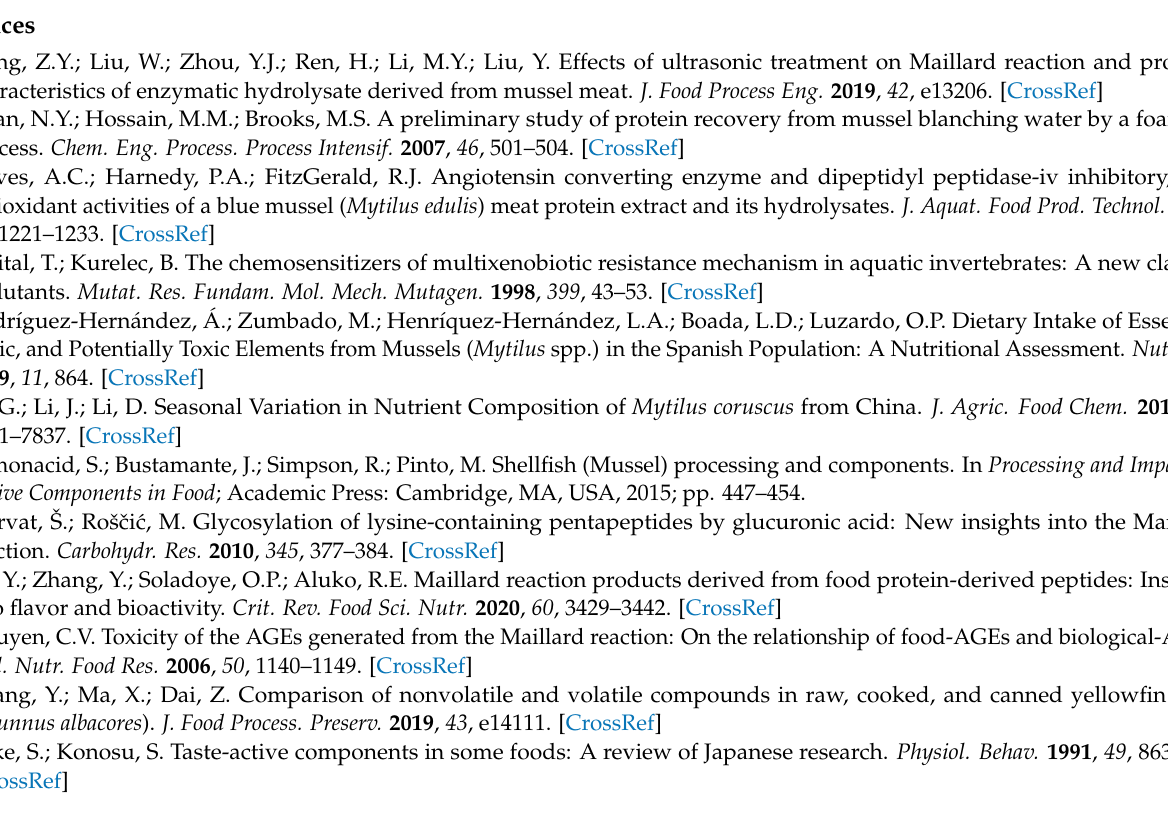
Table S3: Table of changes of volatile matter content in MRPs adding different polar lipids (mg/L); Table S4: Table of changes of amino acids and their derivatives in MRPs with different polar lipids added (mg/100 mL); Table S5: Table of changes of oligopeptides in MRPs with different polar lipids added (mg/100